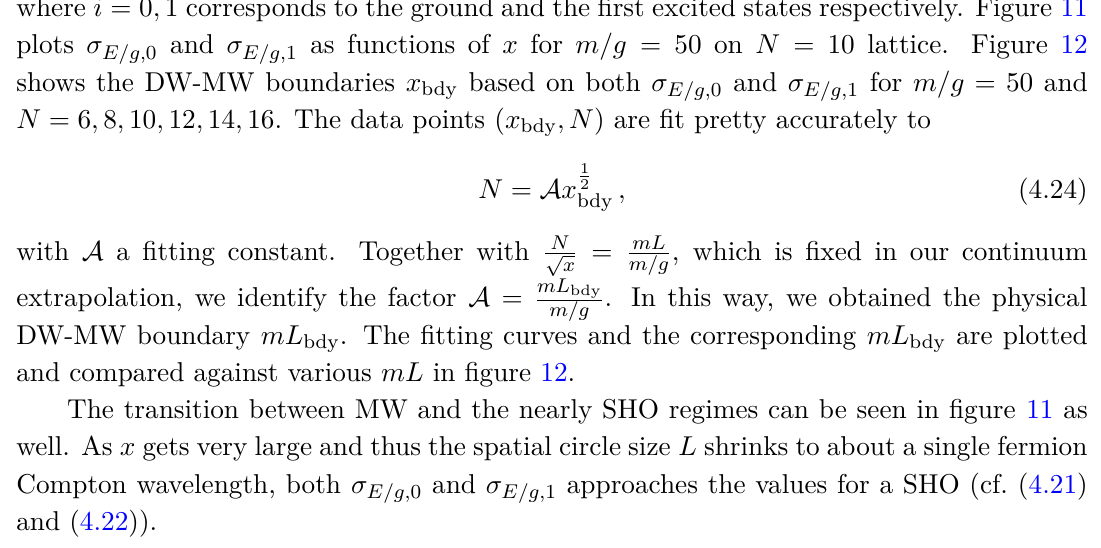
Figure 11. The standard deviations in the spatially averaged electric field for the ground state and for the first excited state σ as functions of x ≡ 1 / ( ga ) 2 on N = 10 lattice with σ E/g, 0 E/g, 1 m/g = 50 and α = 0 . 5 . A smaller spatial circle size corresponds to a larger x according to . The blue and orange points are respectively the lattice data of σ N √ mL = m g x green dot-dashed curve denotes σ for a pure quantum SHO given by (4.21) whereas the red E/g, 0 dotted curve is σ for the SHO given by (4.22). The purple dashed line denotes the constant E/g, 1 = σ = 1 / 2 , which corresponds to the perfect DW σ E/g, 0 E/g, 1